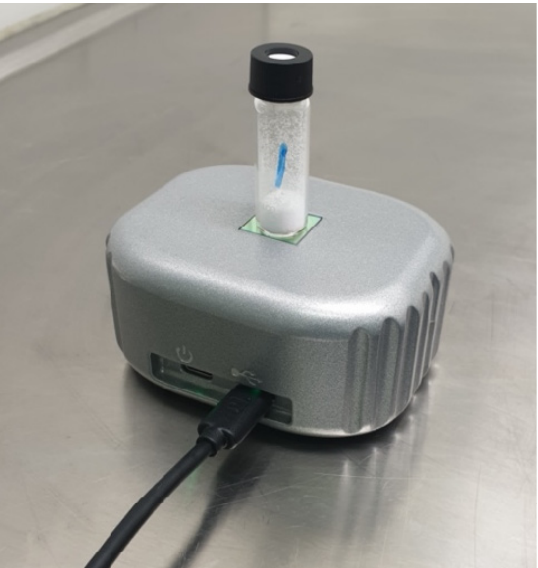
Figure 1. Positioning of a borosilicate glass vial with an energetic material on the scanner of the portable NIR analyzer.